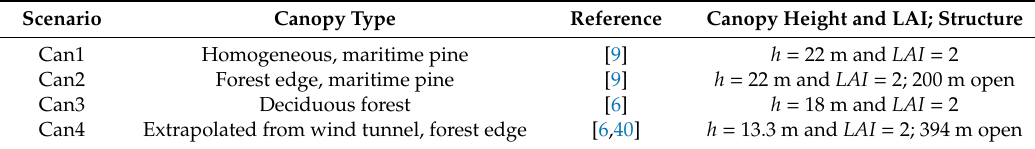
Table 2. Description of the four canopy configurations used in the present